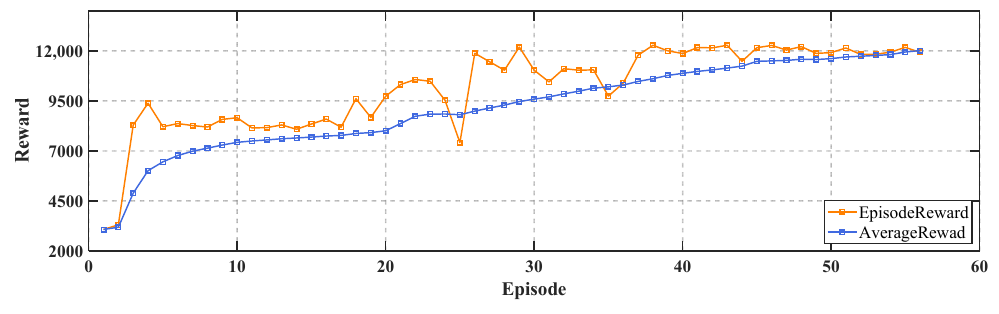
Figure 6. Learning curves.